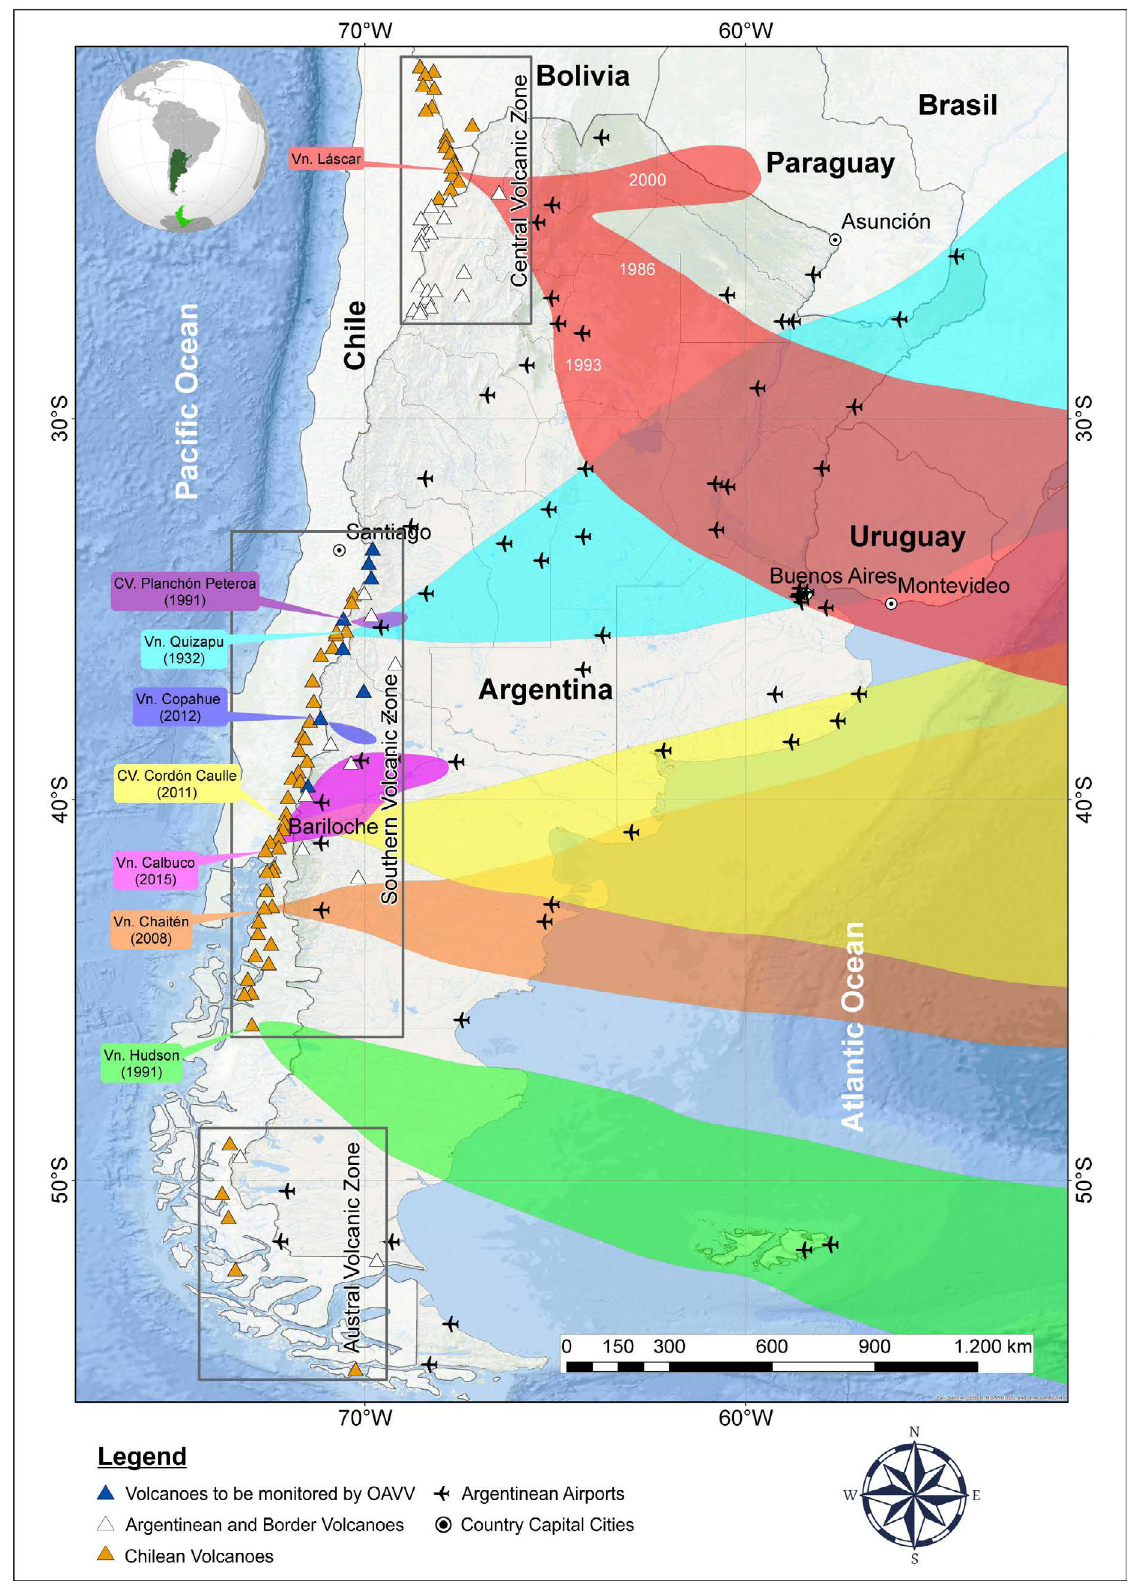
Figure 1: Map showing regions of ash dispersion from the most important historial eruptions that had an effect Argentine territory [modified from Viramonte et al.